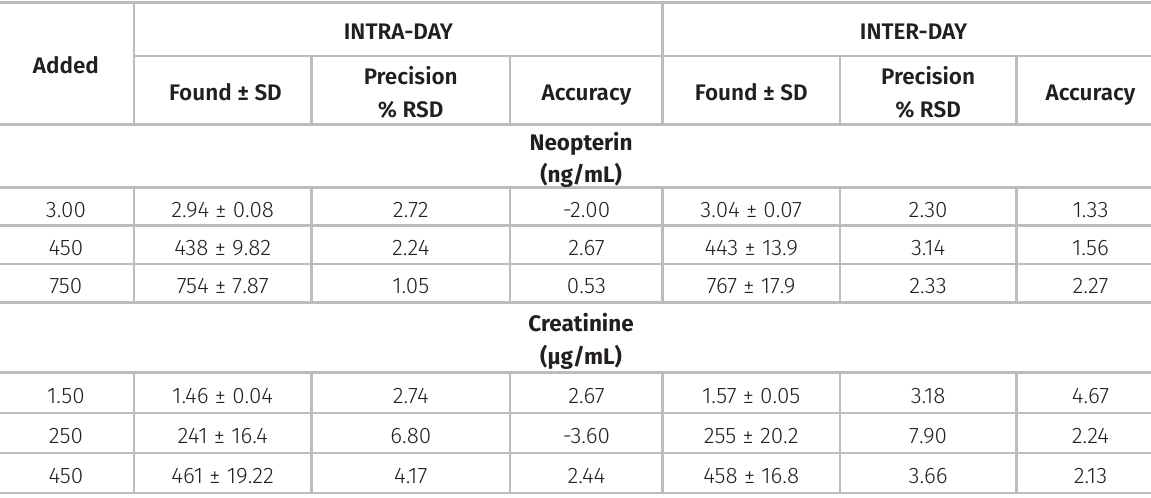
Table II. Precision and accuracy of neopterin and creatinine in human urine.